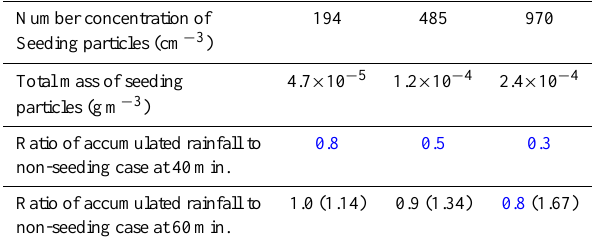
Table 6. Ratios of seeded-case to non-seeded-case accumulated sur- face rainfall averaged over the domain at 40 and 60min. Seeding of shallow convective cloud is carried out with flare particles (up to 5µm in radius). A ratio indicating a decrease is colored blue. Ratios of seeded-case to non-seeded-case (665cm − 3 ) cloud droplet number concentrations at 50m above the base of the cloud center at 11.5min are shown in parentheses.